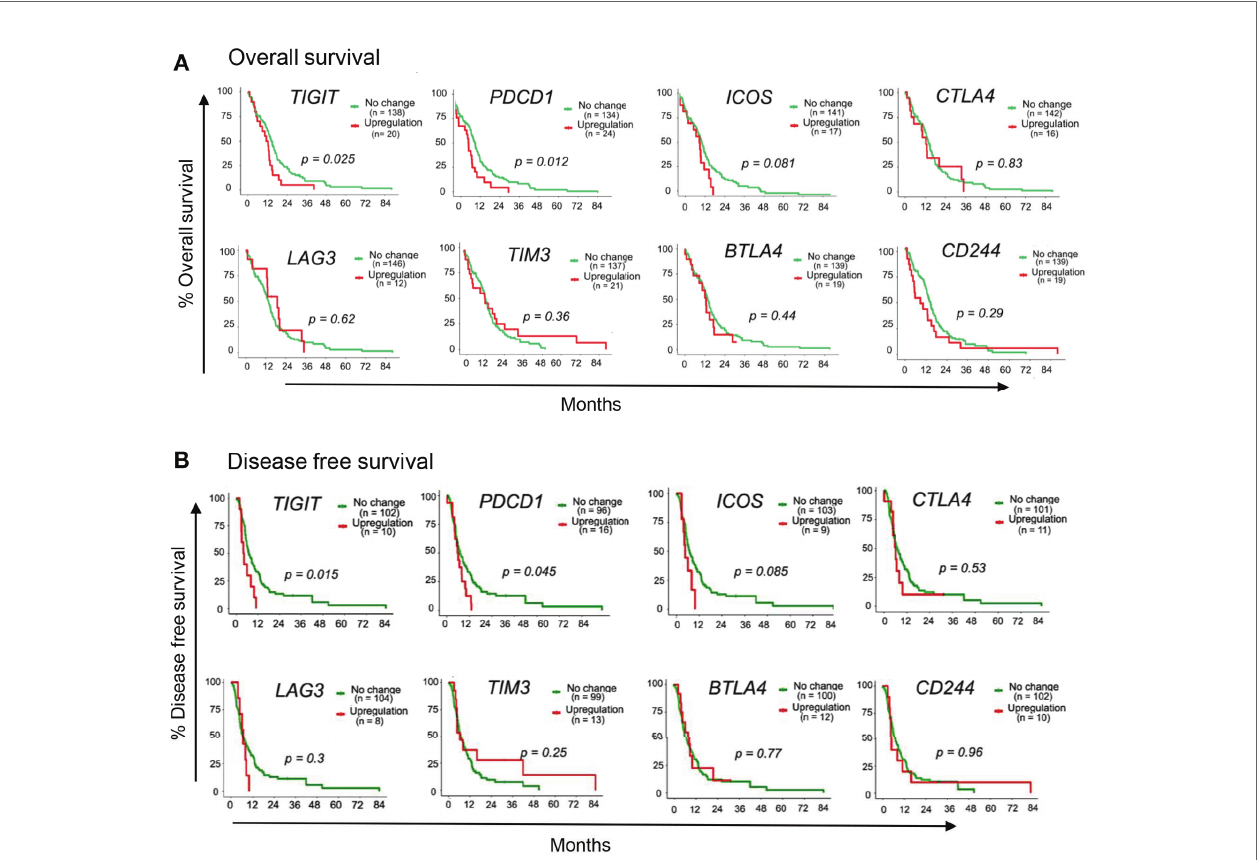
FIGURE 1 | Immune-checkpoint receptor genes associated with GBM patient outcome. TCGA patient survival data obtained from cBioPortal, and patients were grouped based on gene expression z-scores to upregulated expression (z ≥ 2; red line) or no change expression (z <2; green line). The (A) overall survival rate and (B) disease free survival rate, were plotted using Kaplan-Meier survival curves. P values re fl ect one-way ANOVA with Kruskal Wallis comparison test.